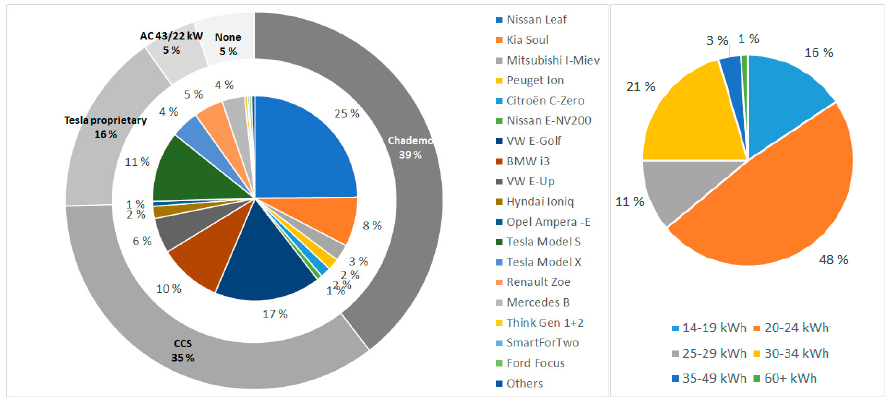
Figure 2. Model fleet shares and share of charging systems ( left ) [7] and non-Tesla BEVs battery size split ( right ). Status as of 01.01.2018 [7,34].